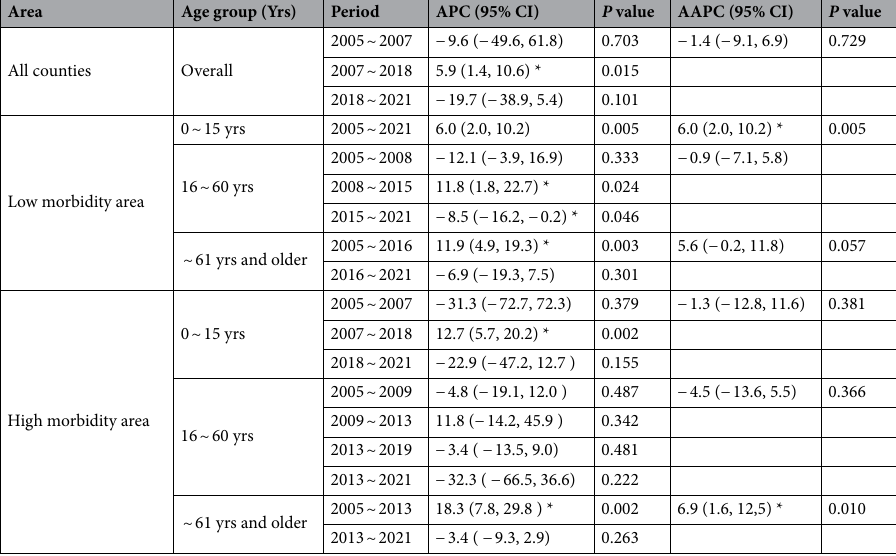
Table 1. Morbidity trend by age according to the join points identified by the